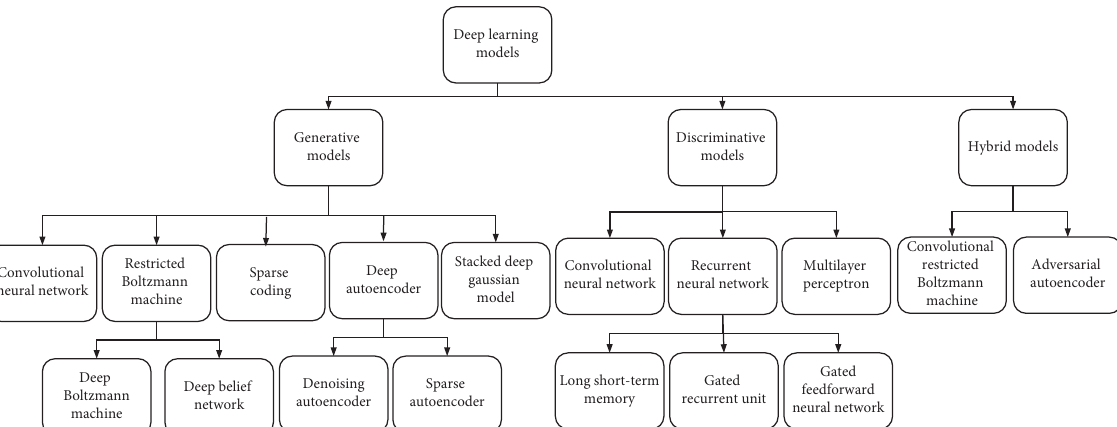
Figure 2: Deep learning models—taxonomy.